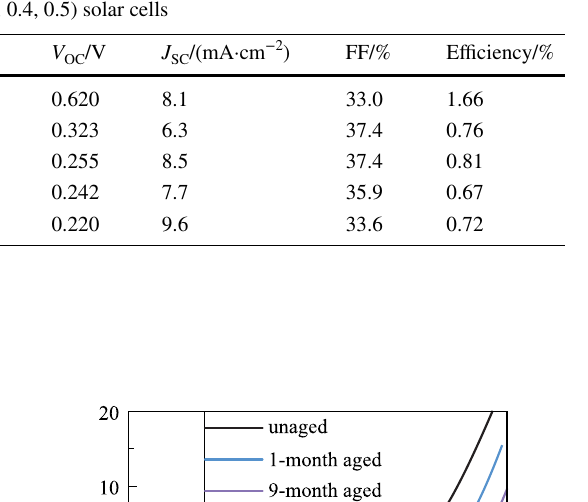
J–V curves of ZnO/